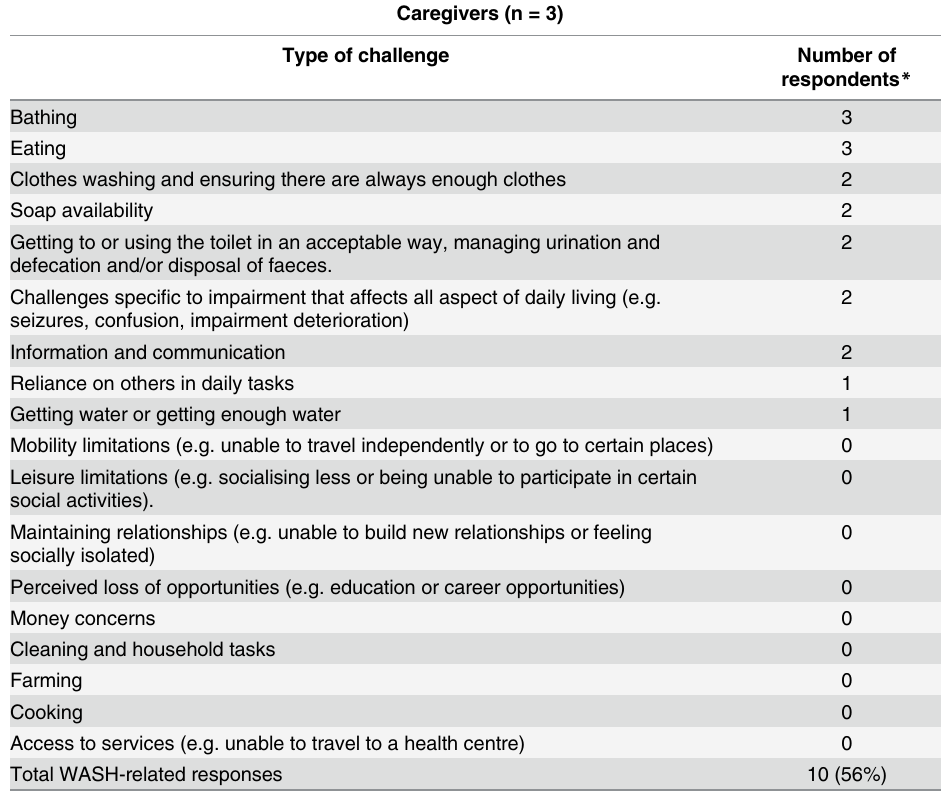
Table 5. Number of caregivers reporting each of the daily